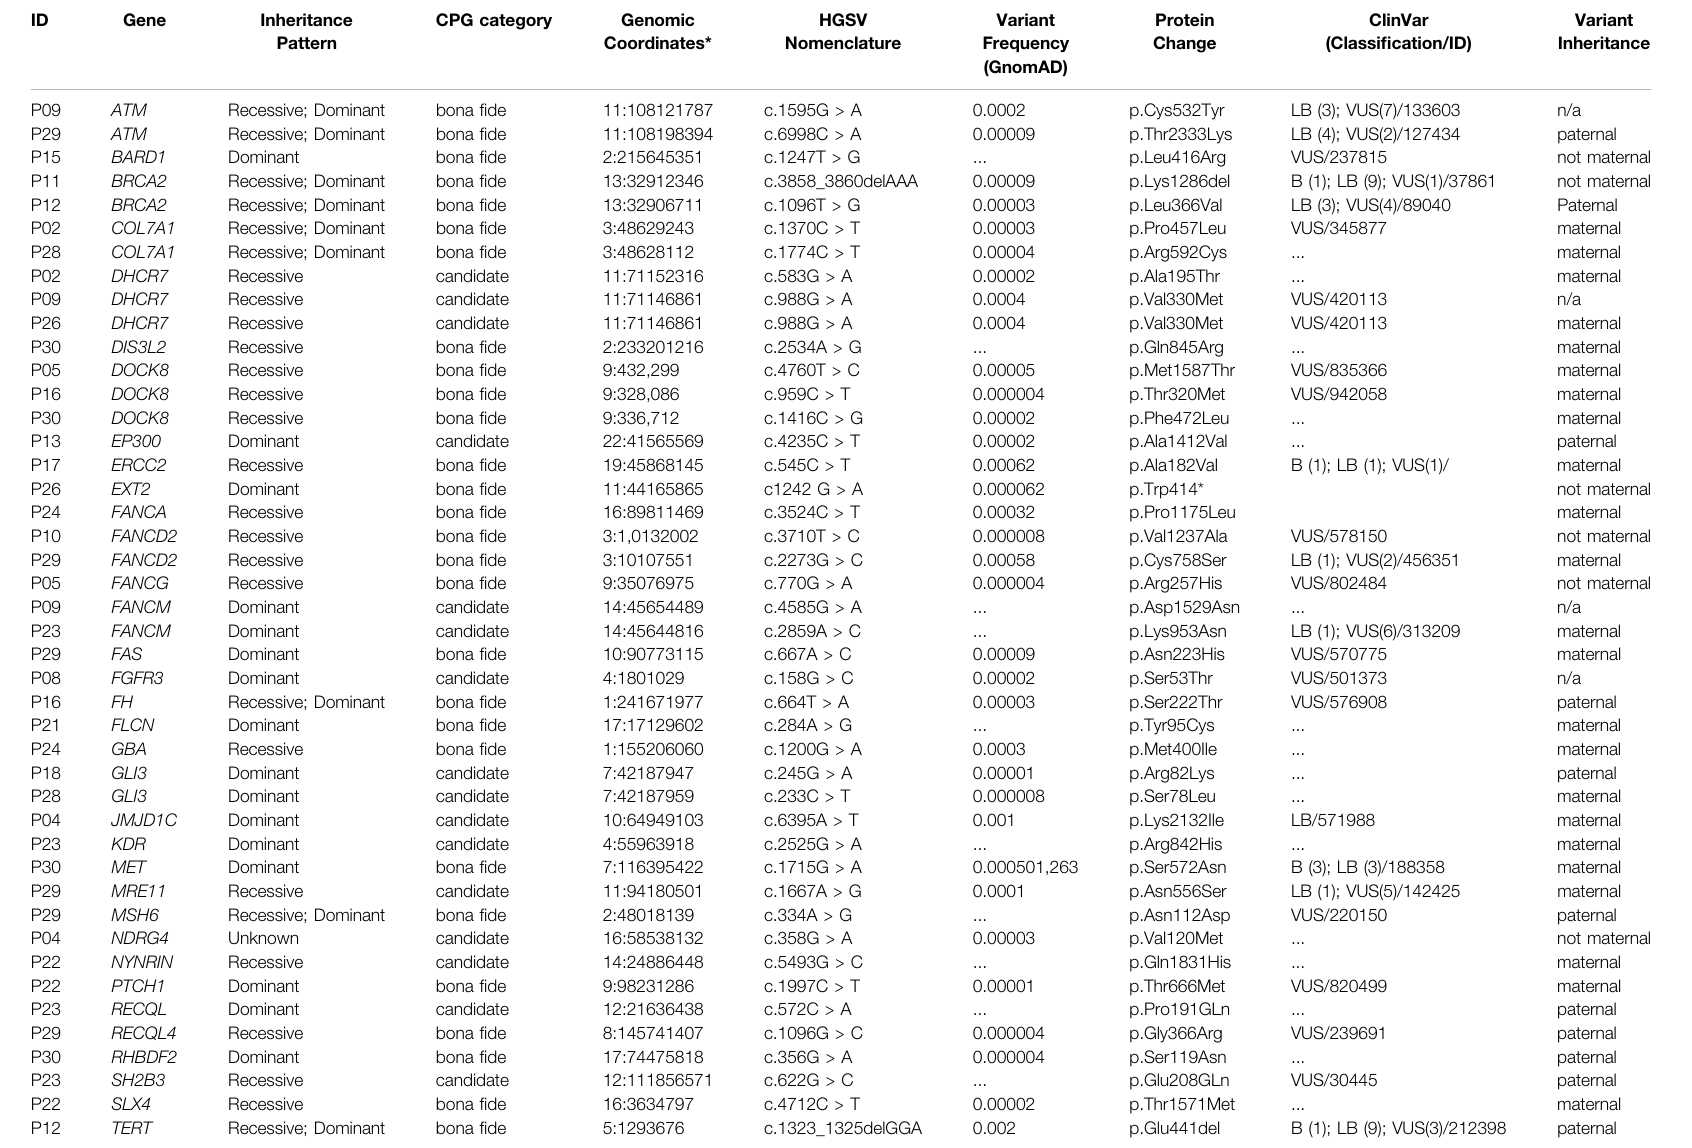
TABLE 3 | Description of 44 germline rare heterozygous variants of uncertain signi fi cance (VUS) mapped to known/candidate cancer predisposition genes detected in 21 hepatoblastoma